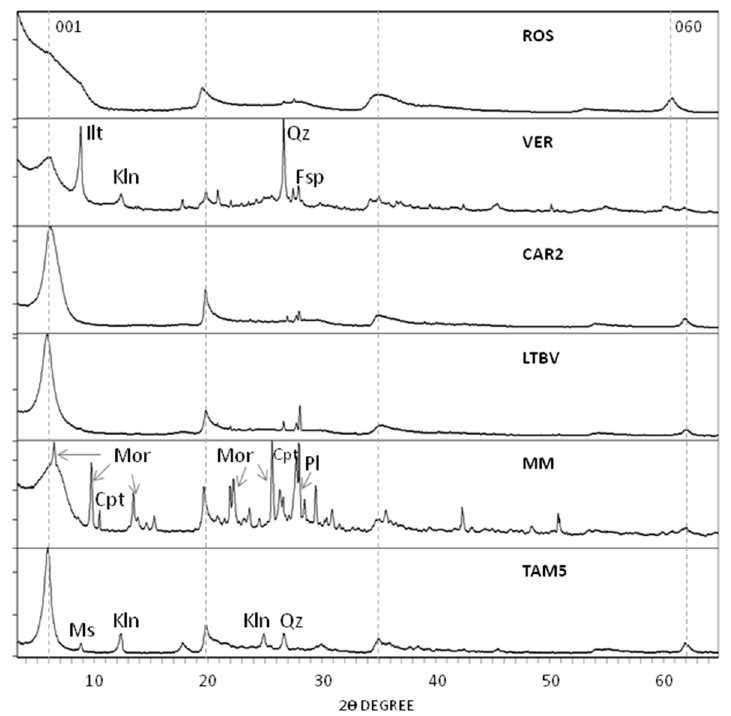
Figure 9. Representative X-ray di ff raction patterns of whole-rock powder samples. Cpt: clinoptilolite, Fsp: feldspar, Illt: illite, Kln: kaolinite, Mor: mordenite, Ms: moscovite, Pl: plagioclase, Qz: quartz. Dashed line, from the left to the right: 001, 020, 131, and 060 smectite reflection.